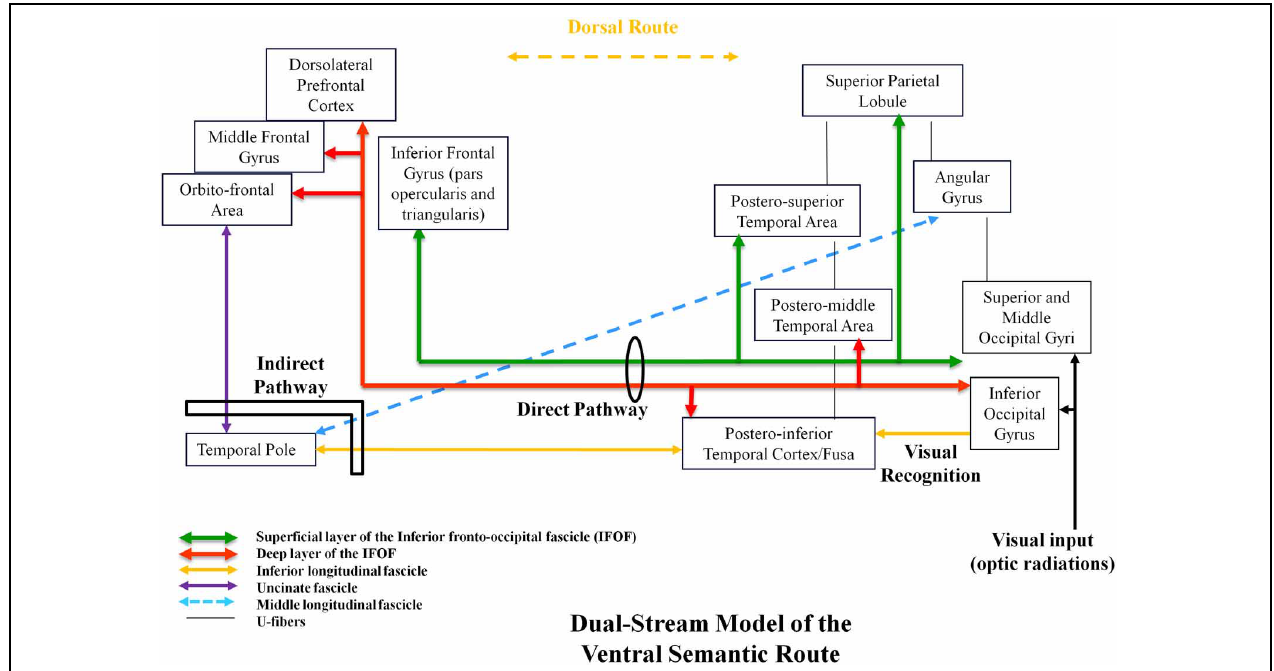
FIGURE 1 | Proposal of a dual-stream model of the ventral amodal semantic route, with incorporation of anatomic constraints, elaborated on the basis of structural–functional correlations provided by intraoperative